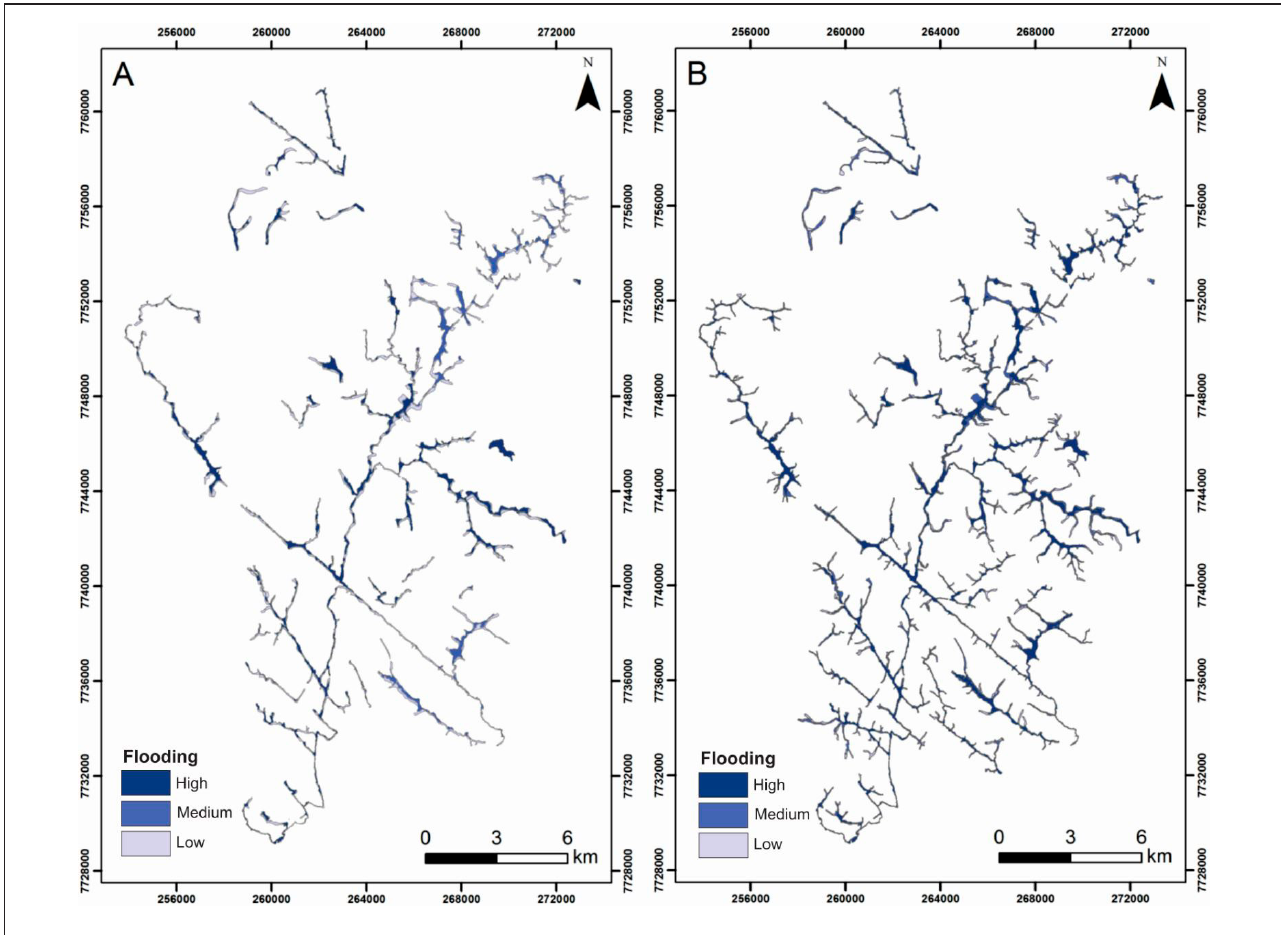
Figure 8 - Flood modeling of Conceição do Castelo, ES. (A) Modeling following the old methodology. (B) Flood modeling using the new methodology that replaces basin information by flood susceptibility of relief patterns.